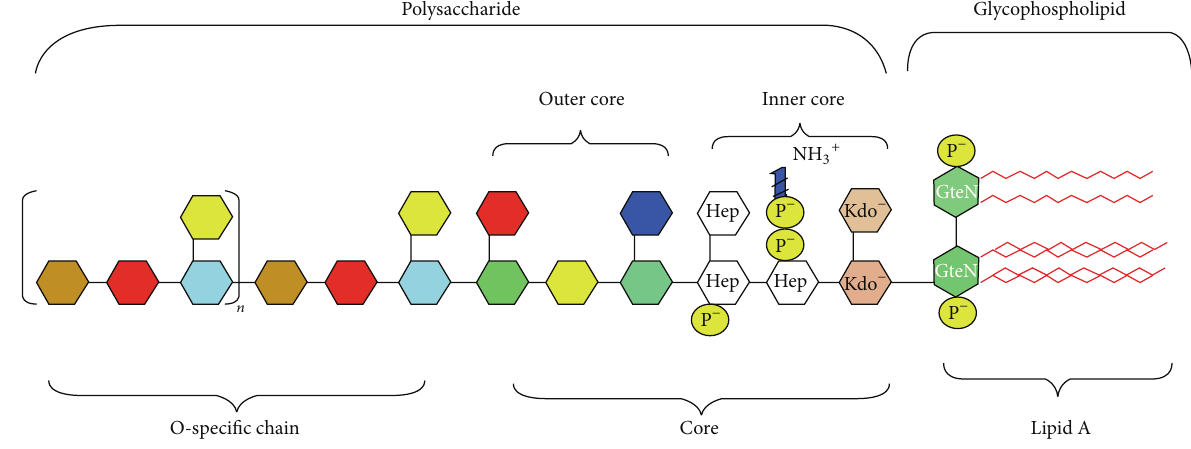
Figure 1: The chemical structure of LPS. Source: